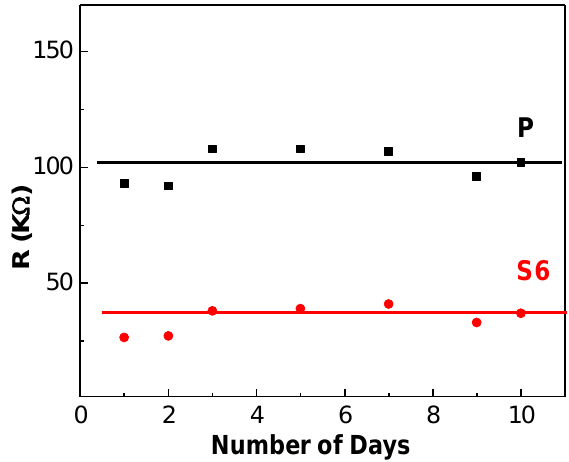
Figure 12. Long-term stability measurements of base resistance for pure and Zn-doped CuO films at an operating temperature of 150 °C. Crystals 2020 , 10 , x FOR PEER REVIEW